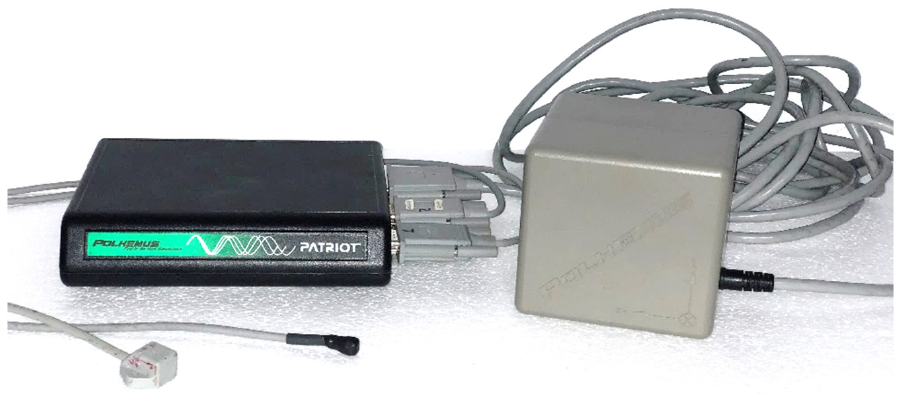
Figure 1. Polhemus Fastrak system. From left to right: receiver module, two sensors, emitter mod- ule.